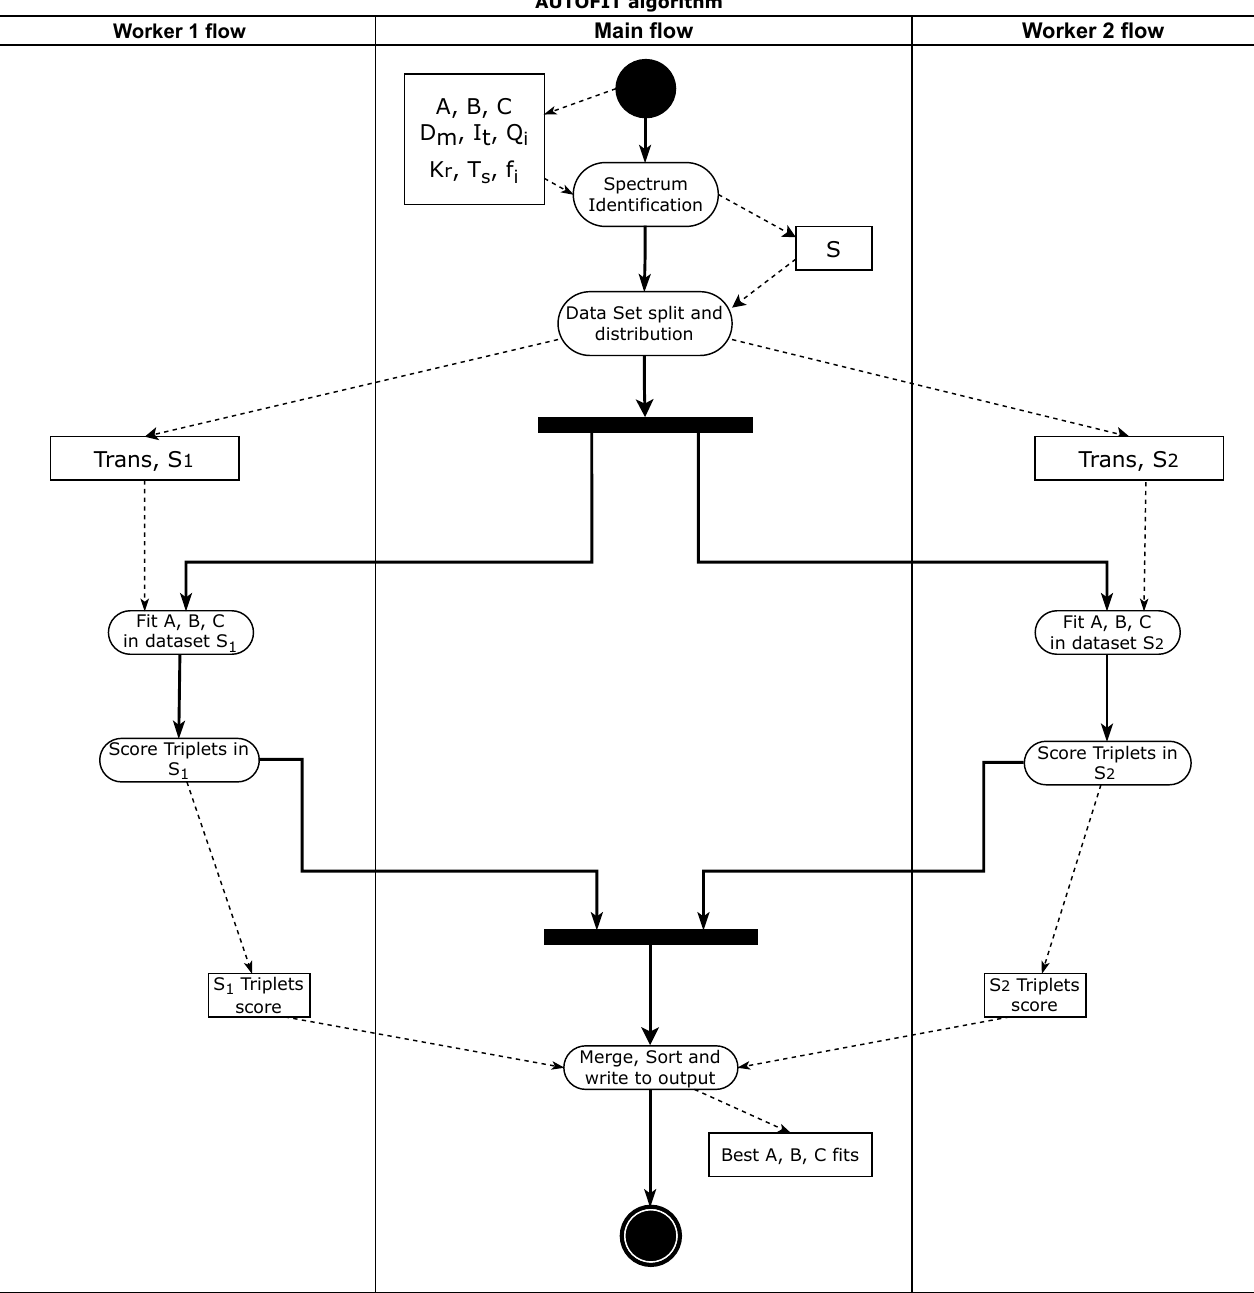
Figure 1. The AUTOFIT